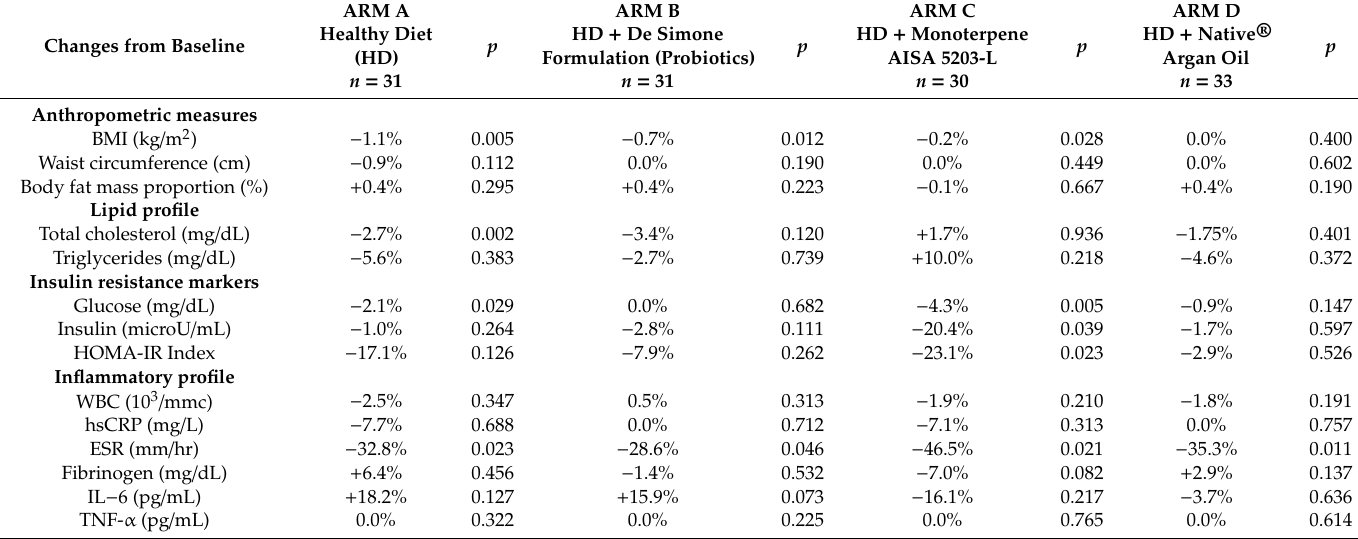
Table 2. Percentage of median change from baseline for anthropometric measures, lipid profile, insulin resistance markers, and inflammatory profile for each dietary arm.